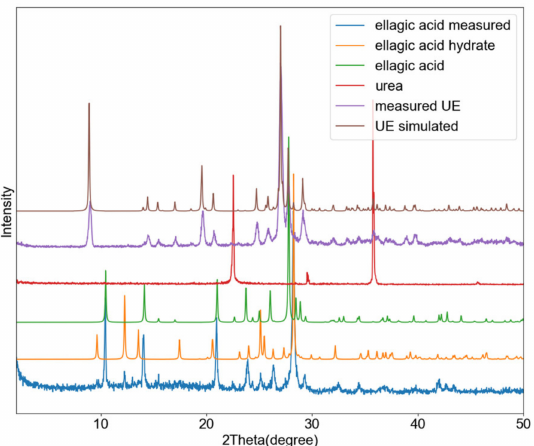
Figure 8. PXRD profiles of ellagic acid ( blue ), simulated ellagic acid hydrate ( orange ), simulated ellagic acid ( green ), urea ( red ), UE co-crystal obtained by grinding ( purple ), the simulated UH pattern ( brown ).